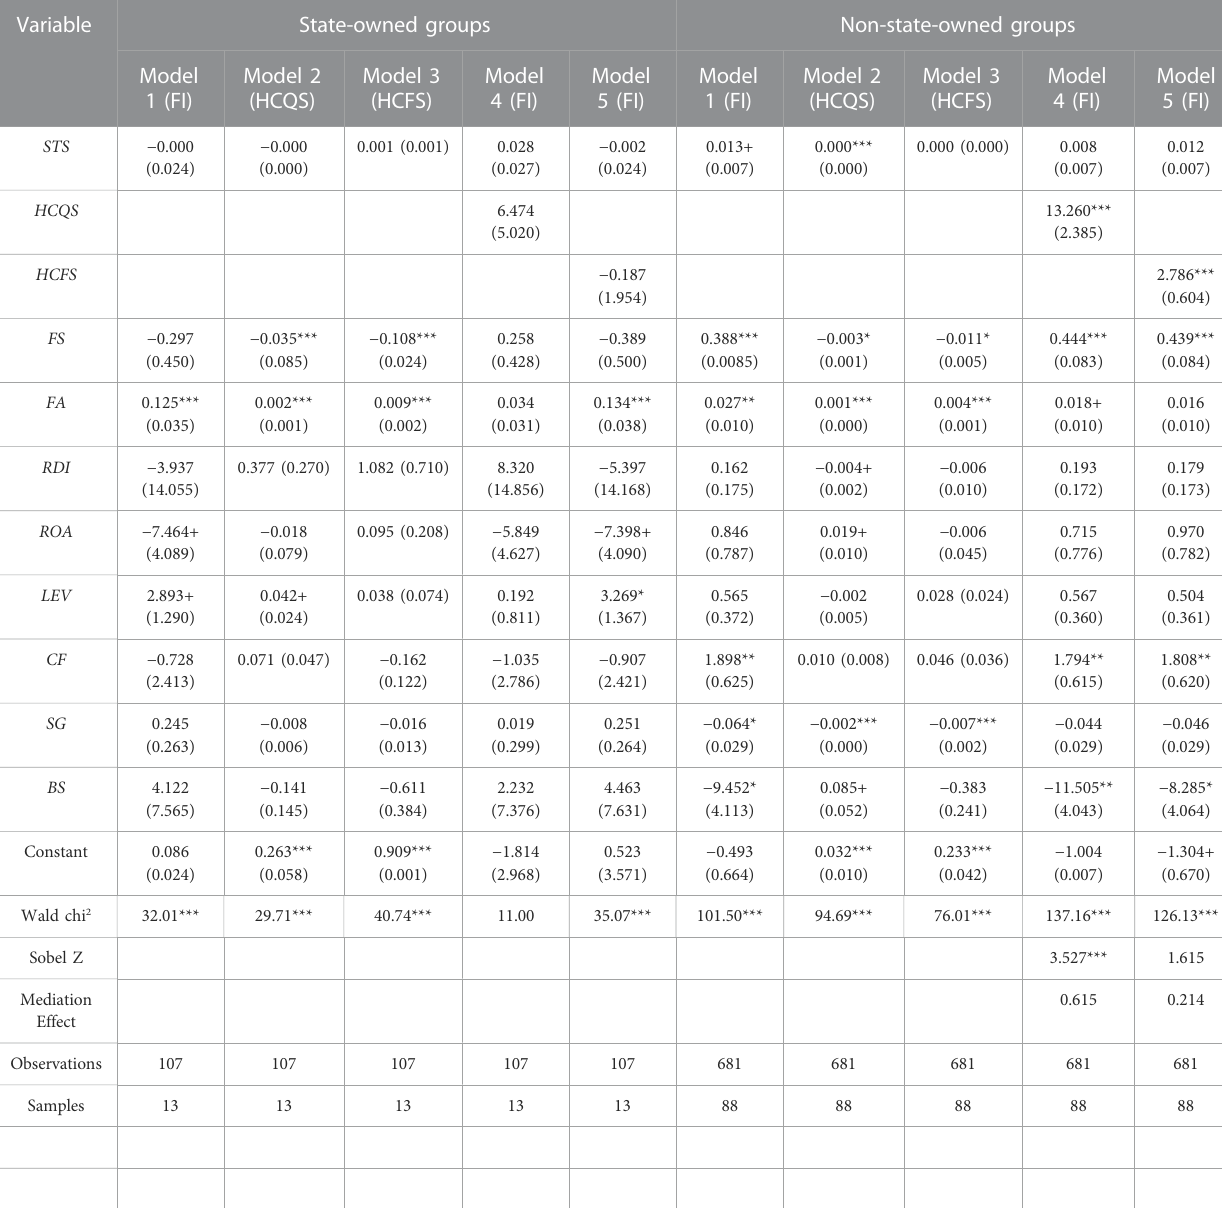
TABLE 12 Regression analysis of state-owned and non-state-owned groups.